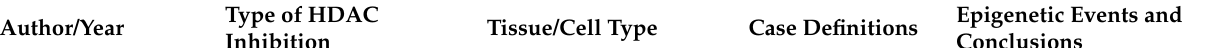
Table 3. Summary of selective publications included for analysis of histone deacetylase inhibitors for treating